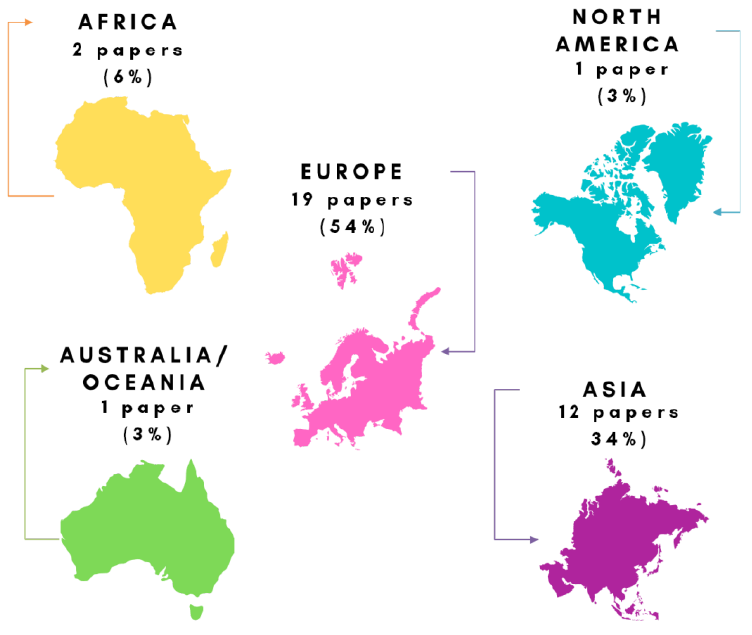
Figure 3. LCA studies based on their continents.